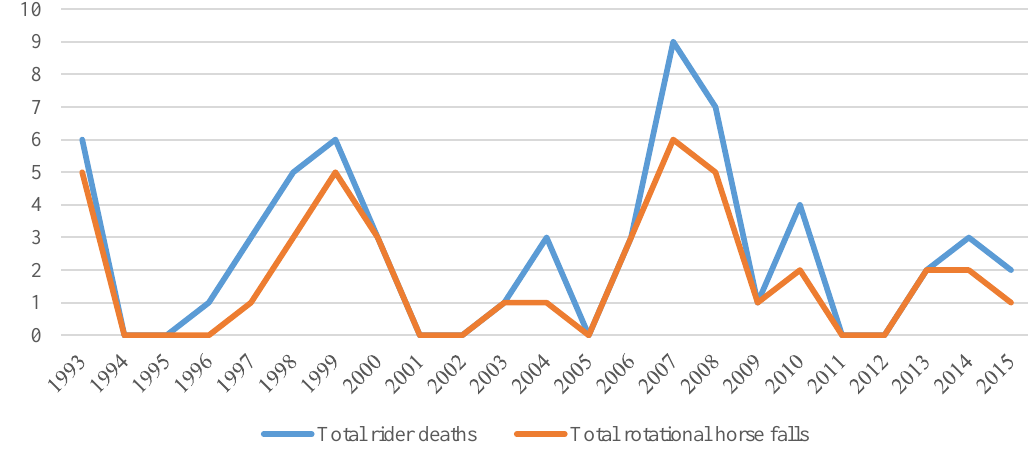
Figure 1. Rotational horse falls and rider fatalities 1993 to 2015.